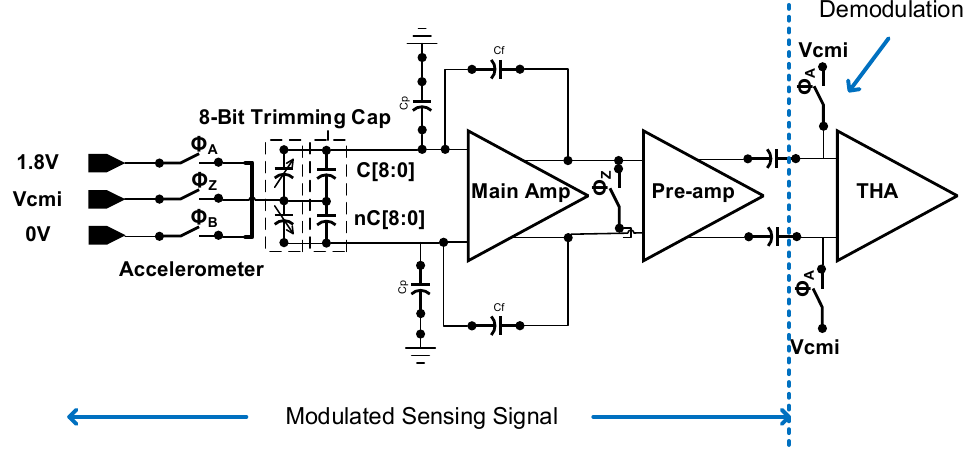
Figure 4. The simplified architecture in Reference [1].